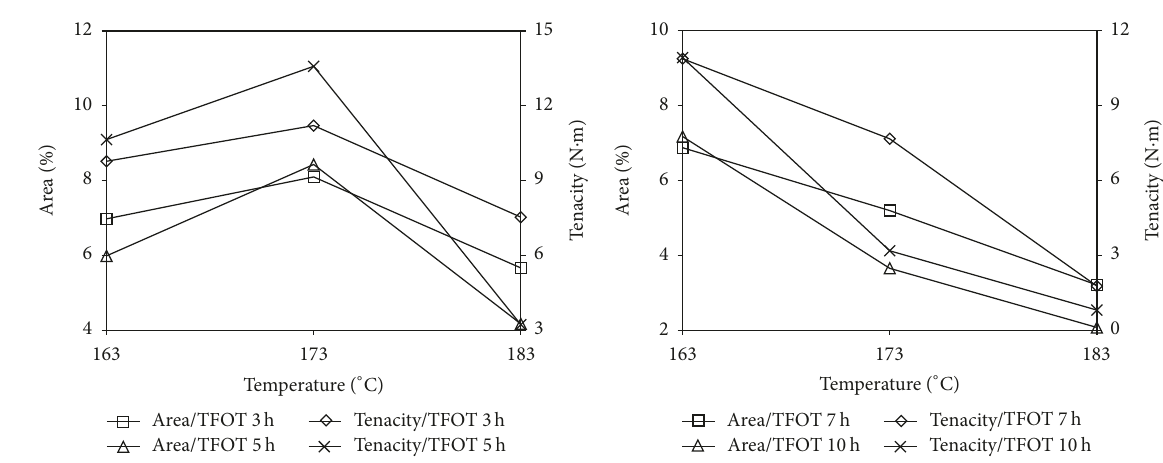
Figure 6: Correlation of SBS particle area and tenacity with aging